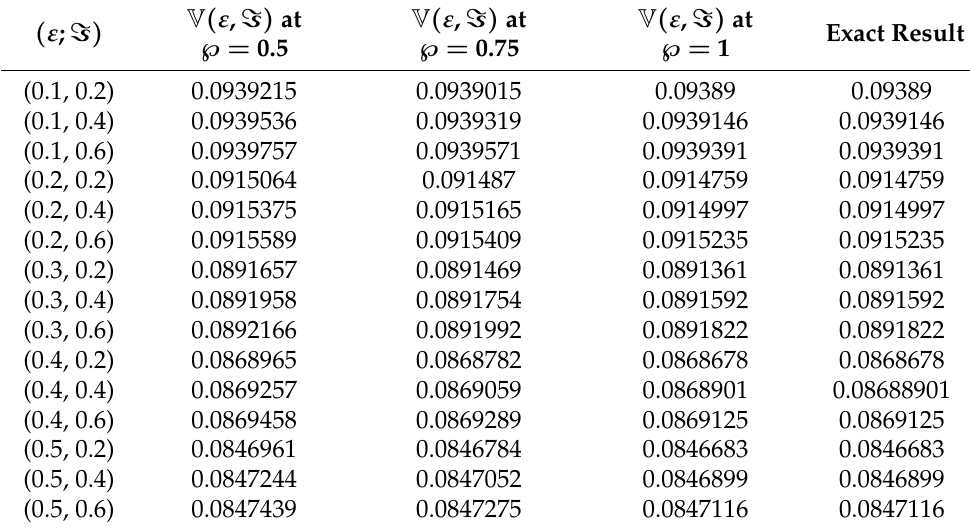
Table 6. YDM solution of V ( ε , (cid:61) ) at different fractional-order ℘ of Example 2. V ( ε , (cid:61) ) at ( ε ; (cid:61) ) ℘ = 0.5